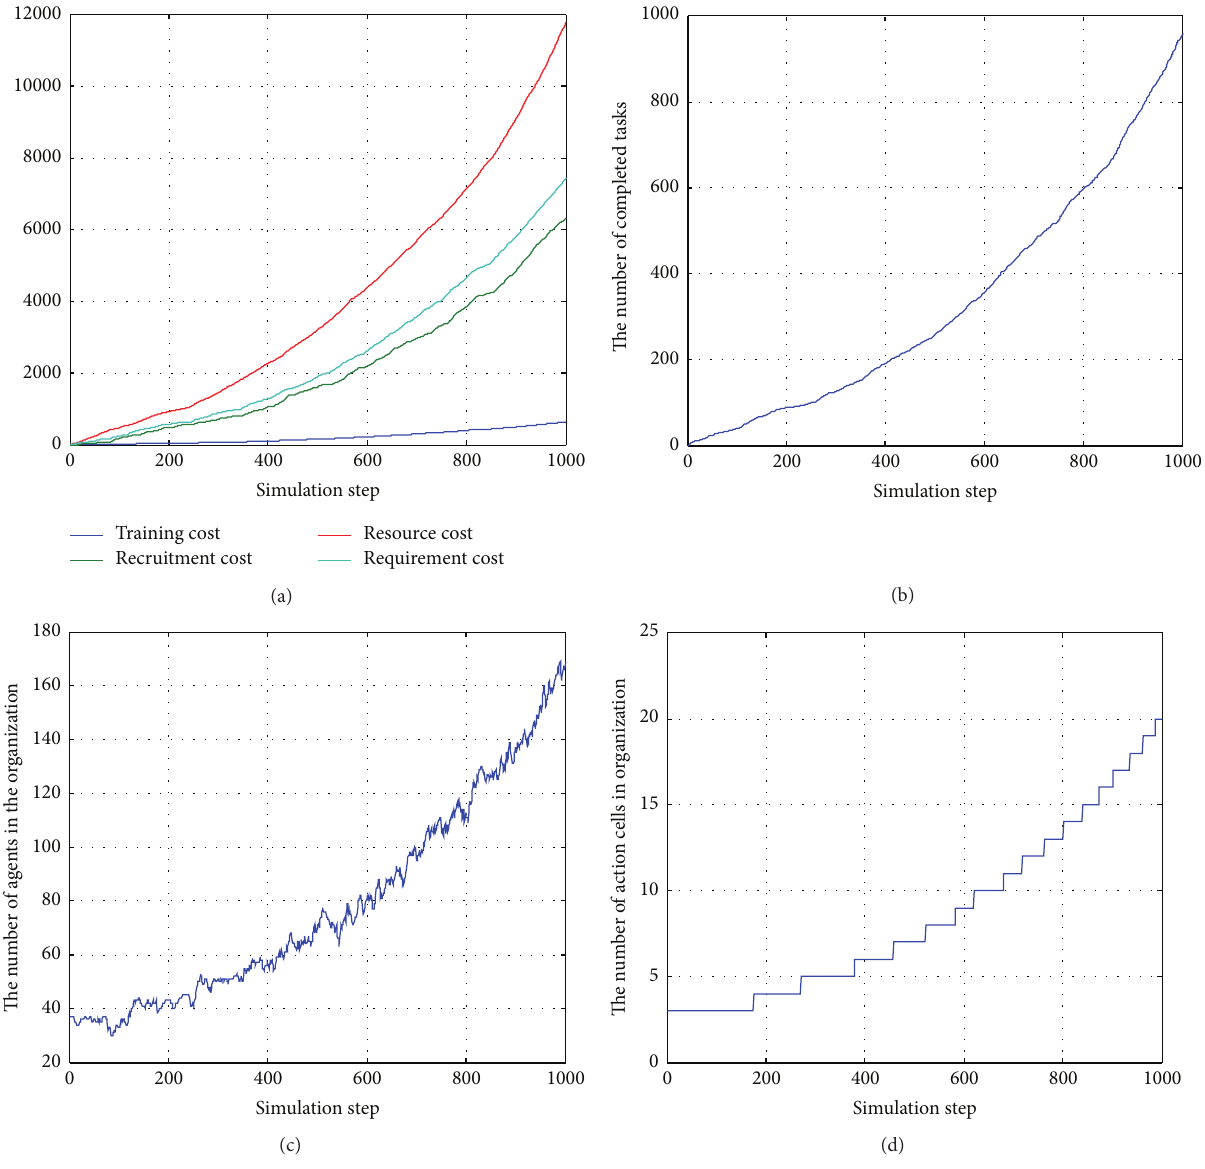
Figure 8: Simulation results of organizational performance, (a) the cost during the simulation period, (b) the number of completed tasks, (c) the number of agents in the organization, (d) and the number of action cells in the